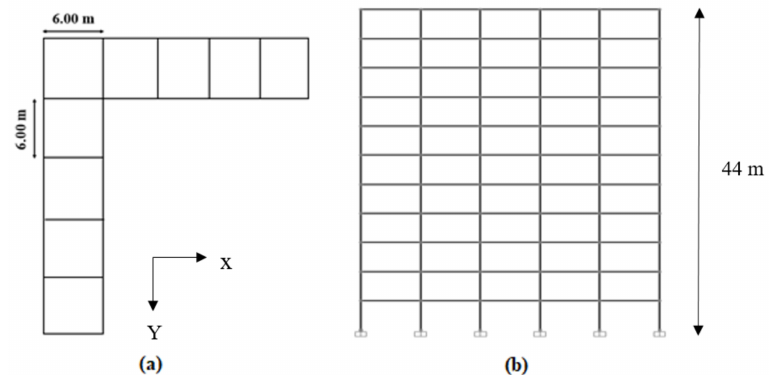
Figure 1. Geometric orientation of unsymmetrical building: ( a ) plan view; ( b ) elevation.